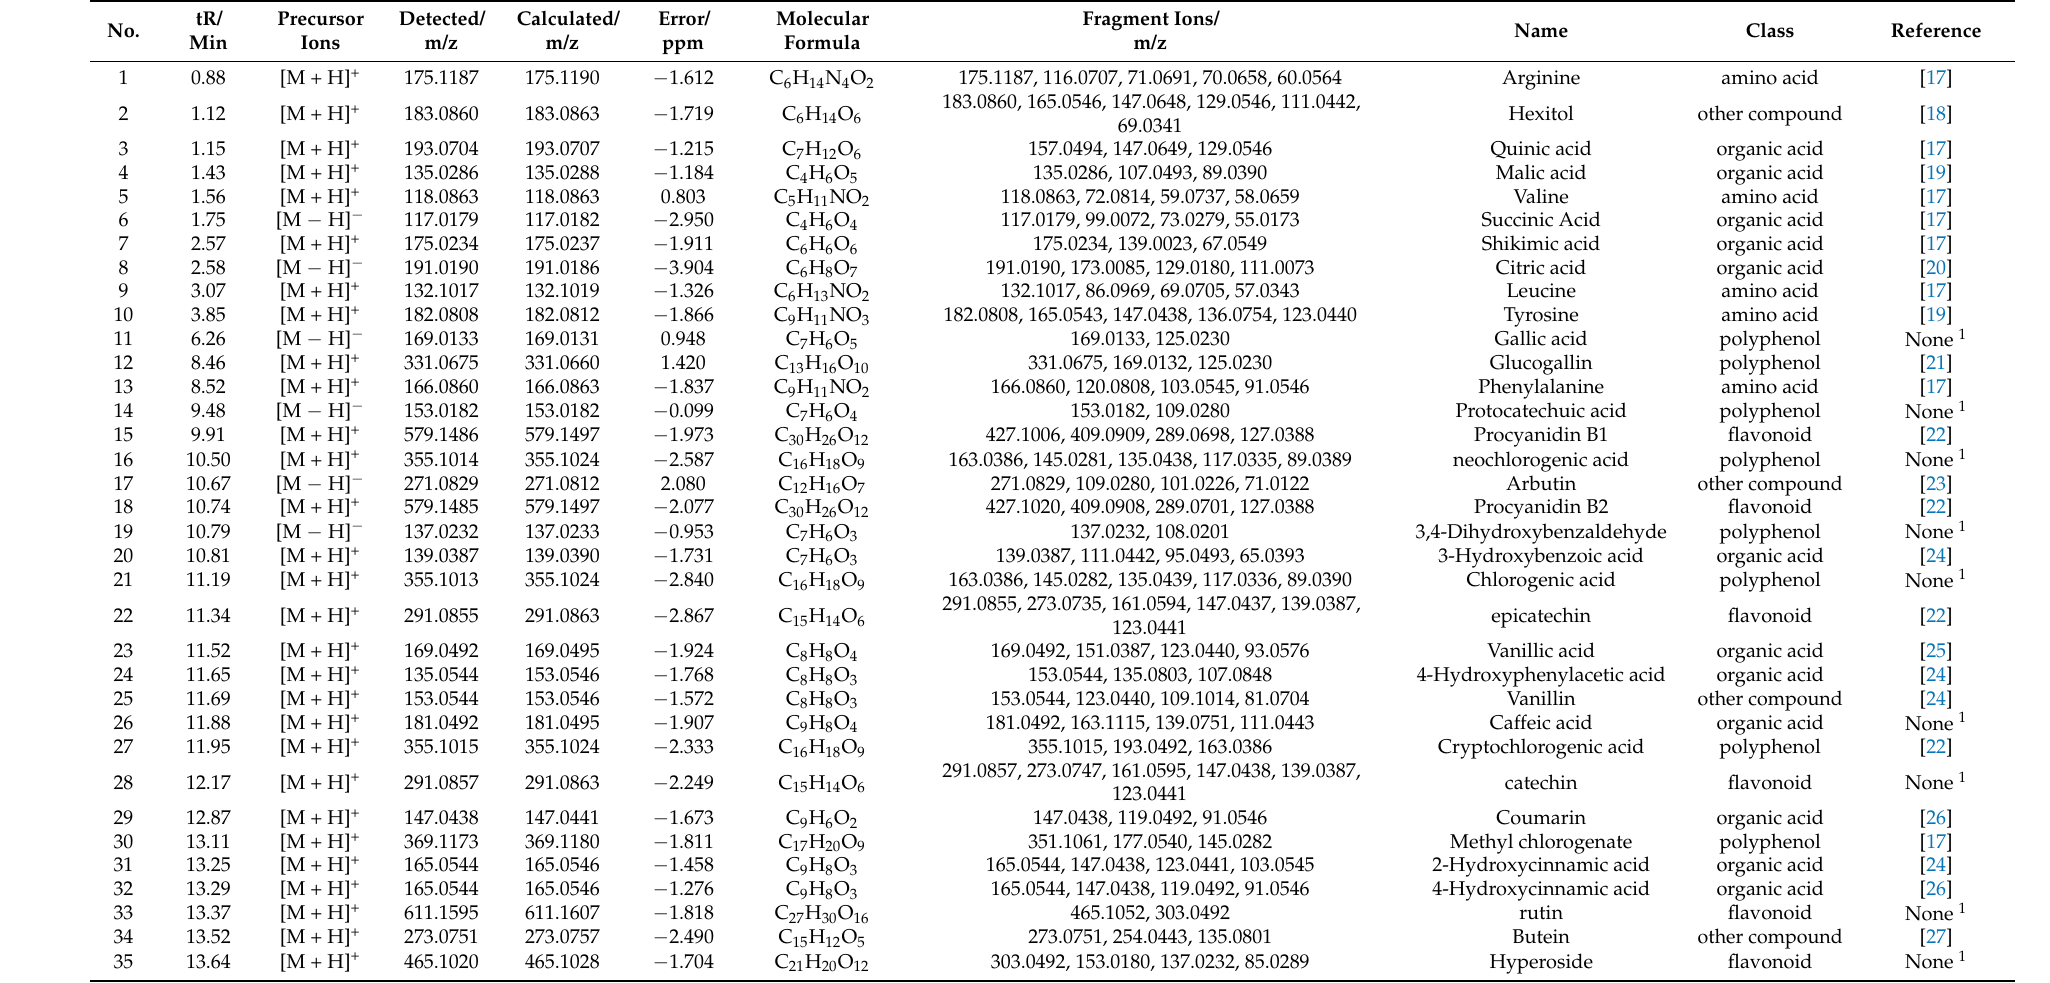
Table 1. The data of components identified from COMF by ESI-Q-Exactive